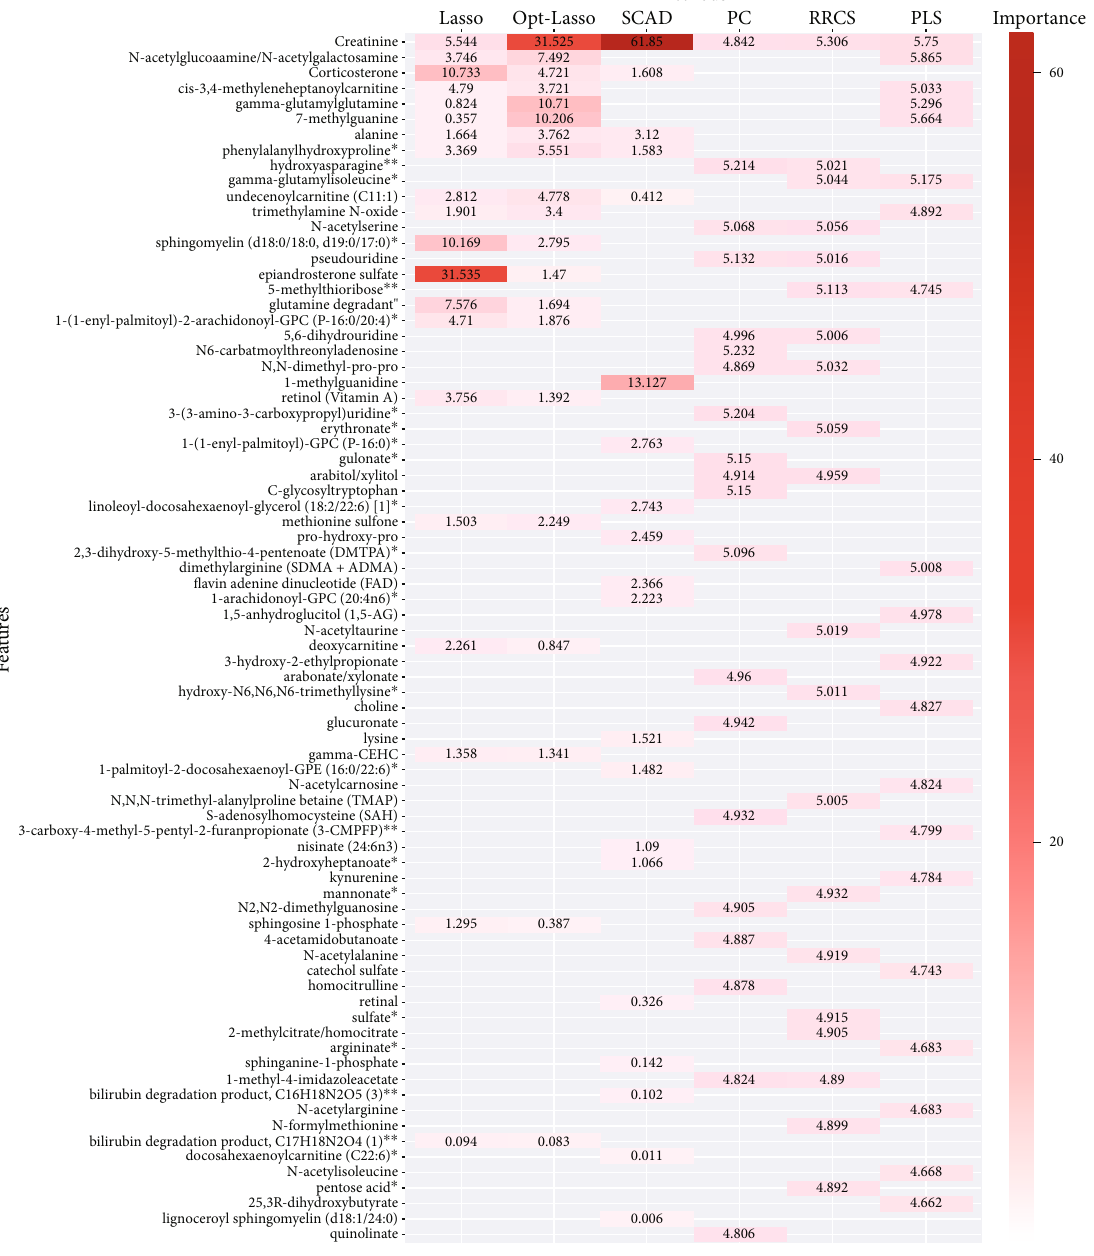
Figure 4: Feature selection using 6 statistical methodologies in the form of a heat